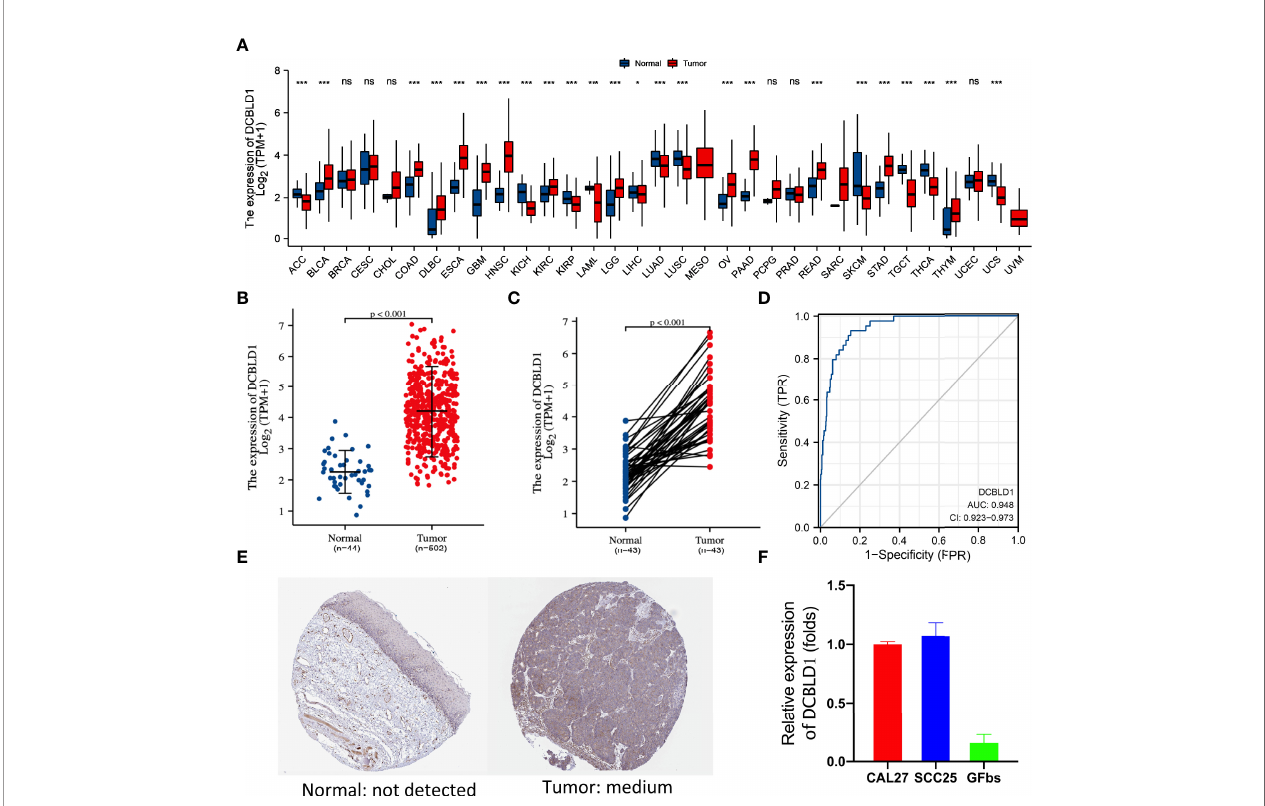
FIGURE 1 | DCBLD1 expression in HNSCC patients. (A) DCBLD1 expression level in pan-cancer analysis from the TCGA database. (B) DCBLD1 expression in normal ( n = 44) and HNSCC ( n = 502) patients. (C) DCBLD1 expression in cancer samples and matched normal tissues. (D) Receiver operating characteristic (ROC) curve analysis of DCBLD1 in HNSCC. (E) Immunohistochemical analysis of DCBLD1 from the Human Protein Atlas. (F) The level of DCBLD1 mRNA expression in CCL27, SCC25, and gingival fi broblasts.